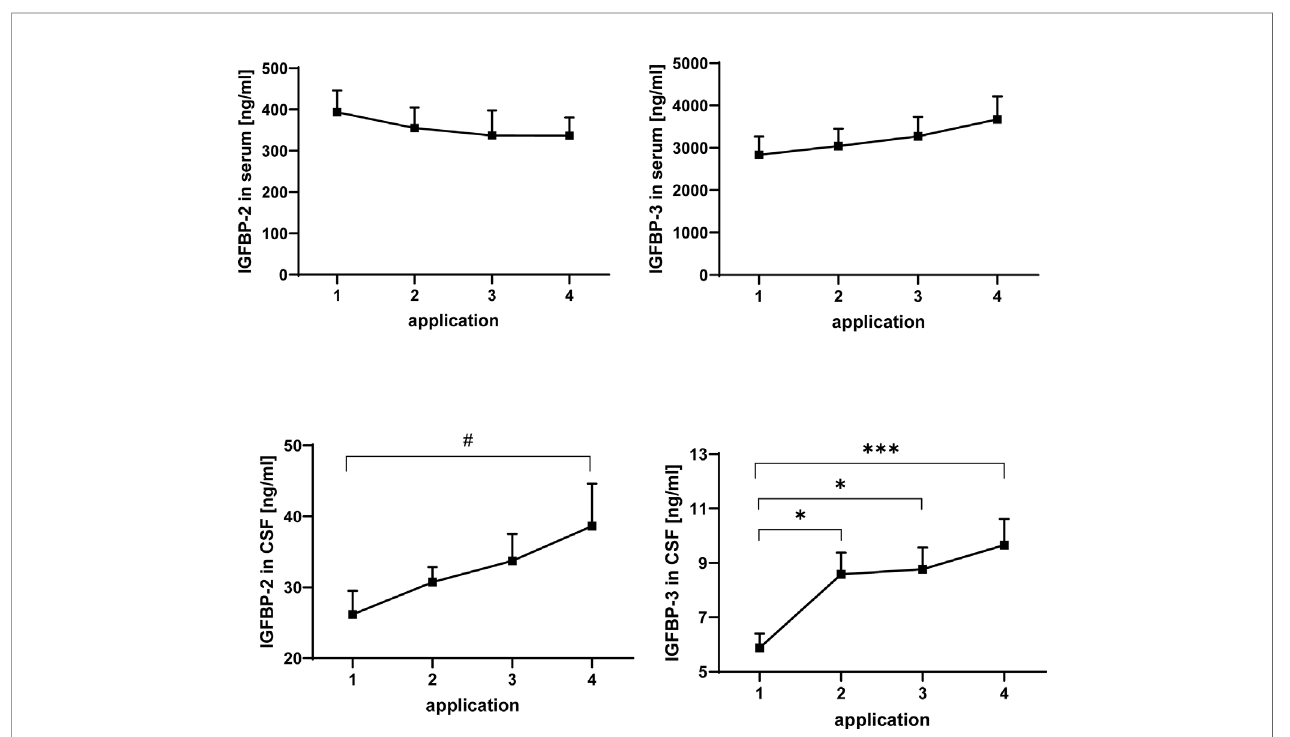
FIGURE 3 | Concentrations of IGFBP-2 (left panels) and IGFBP-3 (right panels) in serum (upper panels) and CSF (lower panels) in MS patients at the time points of intrathecal TCA injection. The data are based on sample series from 20 treatment cycles (14 cycles in four males and 6 cycles in two females) and are given as means ± SEM ( # p < 0.067; *p < 0.05; ***p <